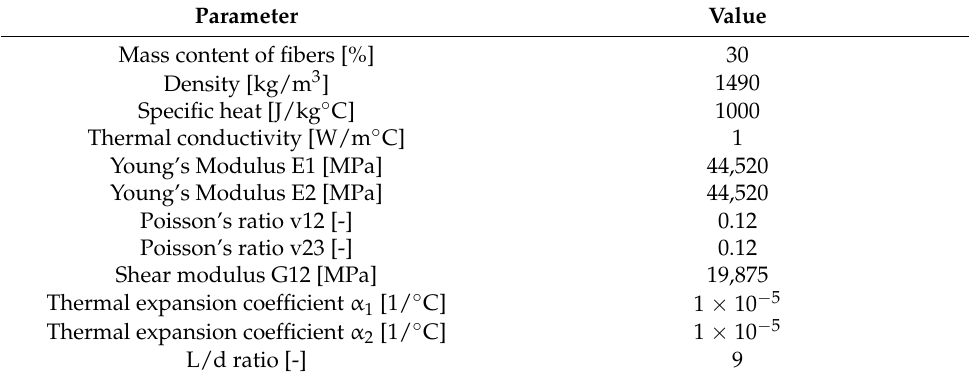
Table 5. Hemp fiber properties used in the calculations [53,54].